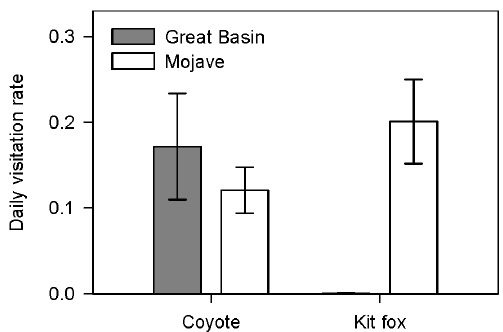
Figure 6. Mean daily visitation rates ( 6 SE) of canids to sources of free water. We defined daily visitation rate as the number of species visits/the number of operable camera trap days per water source. Data were collected on coyotes ( Canis latrans ) and kit foxes ( Vulpes macrotis ) in the Great Basin and Mojave Deserts, USA, 2010 to